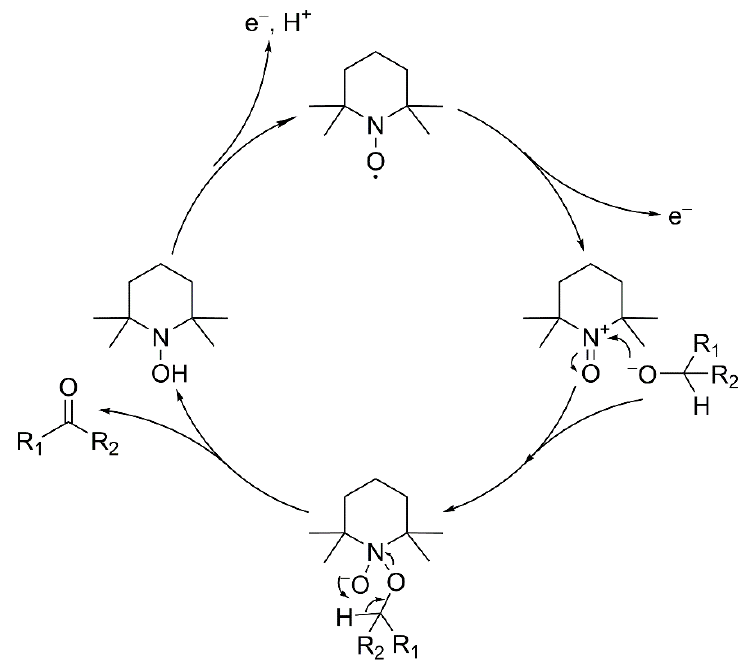
Figure 11. Catalytic cycle of the TEMPO-mediated oxidation of alcohol.